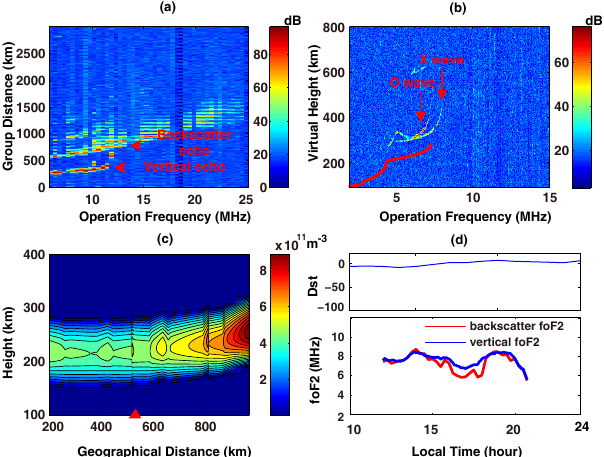
Fig. 7. Same as in Fig. 3, except for the 7 November 2012 experi- ment illustrated in Fig.